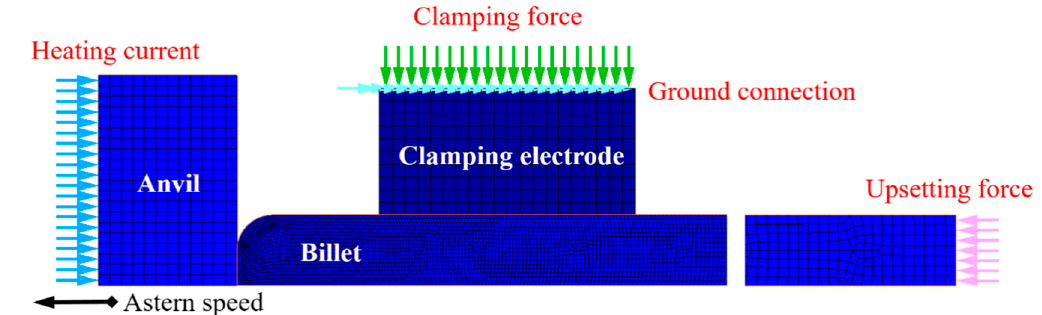
Figure 5. Half-symmetry 2D finite element model of electric upsetting process. Table 1. Chemical composition of Ni80A superalloy.